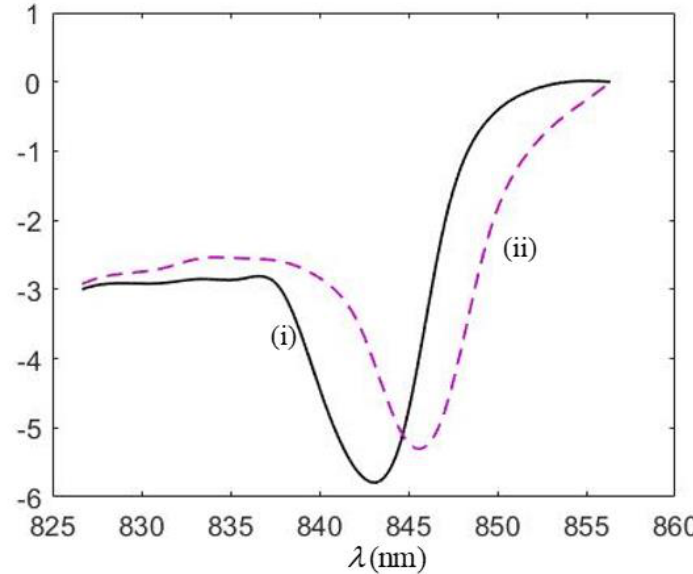
Figure 5. The natural log of I ( λ , d ) for d = 150 µ m corresponding to the two α ( λ ) curves in Figure 3. (i) 1.6 × 10 4 V/cm and (ii) 10 5 V/cm.